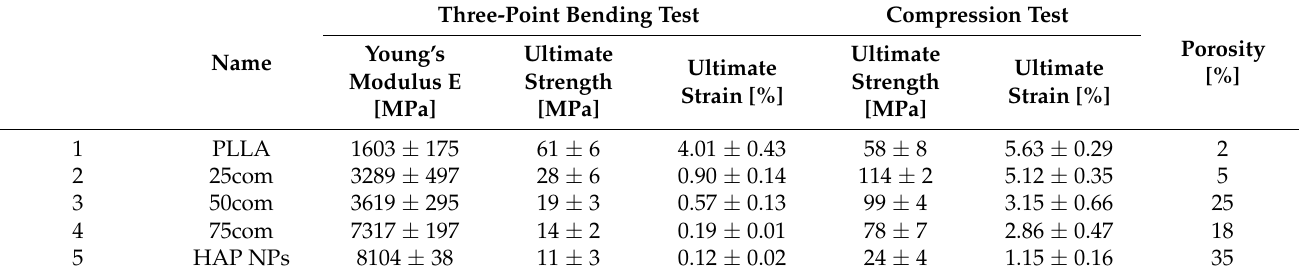
Table 3. Changes in mechanical properties of composites, indicating changes in line with increase in HAP NPs in composite.